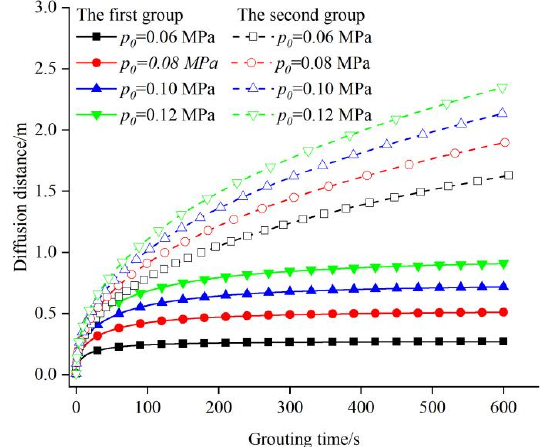
Figure 5. Relationship between diffusion distance and time under different pressures. Two groups of data exist in the figure: the data considering the displacement effect and the data without considering the displacement effect. The two groups of data in Figures 5–7 have the same meaning as Figure 5.